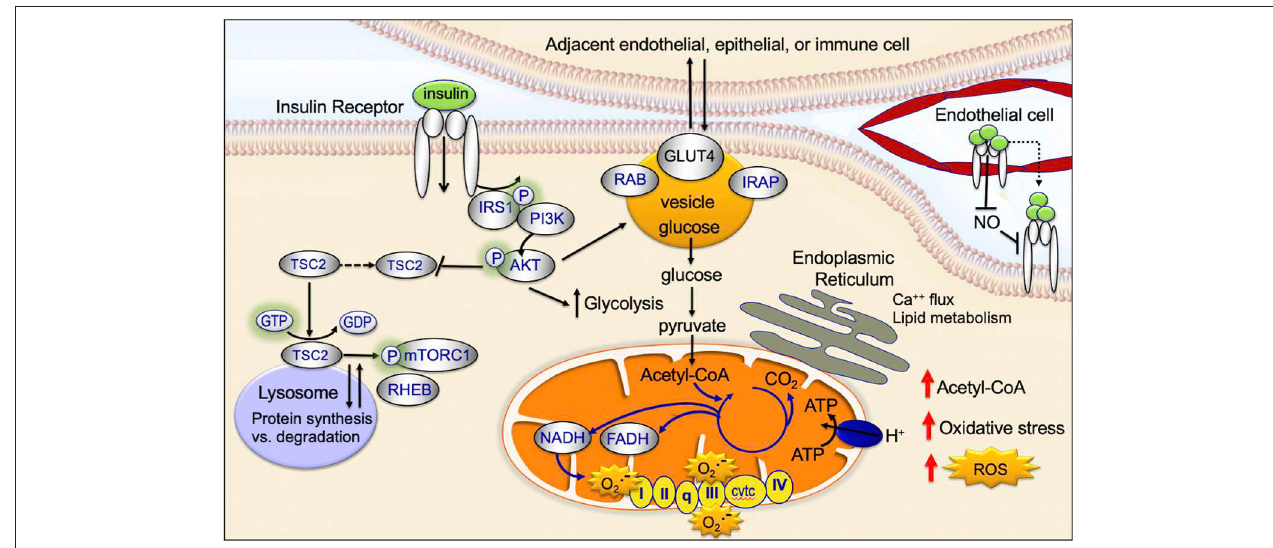
FIGURE 4 | Impact of insulin signaling on subcellular